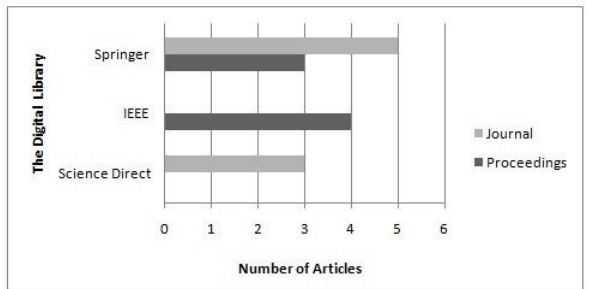
Figure 2: Journals and Proceedings of Search Results